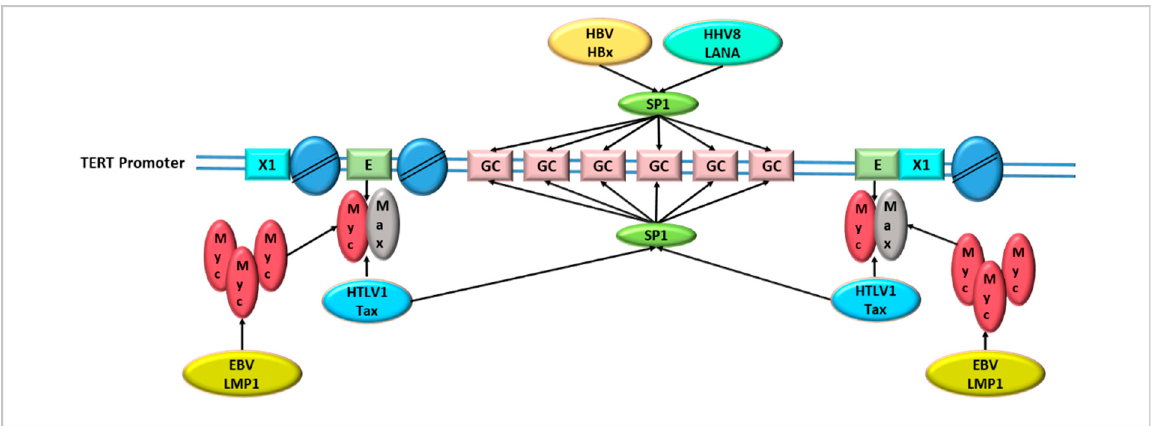
Figure 2. Common strategies adopted by oncoviruses to regulate telomerase activity at transcrip- tional level: HHV8 LANA and HBV HBx are able to stabilize the binding of SP1 to GC-binding sites, HTLV1 Tax facilitates the binding of MYC/MAX to E-boxes and EBV LMP1 recruits MYC on the cognate binding sites on TERT